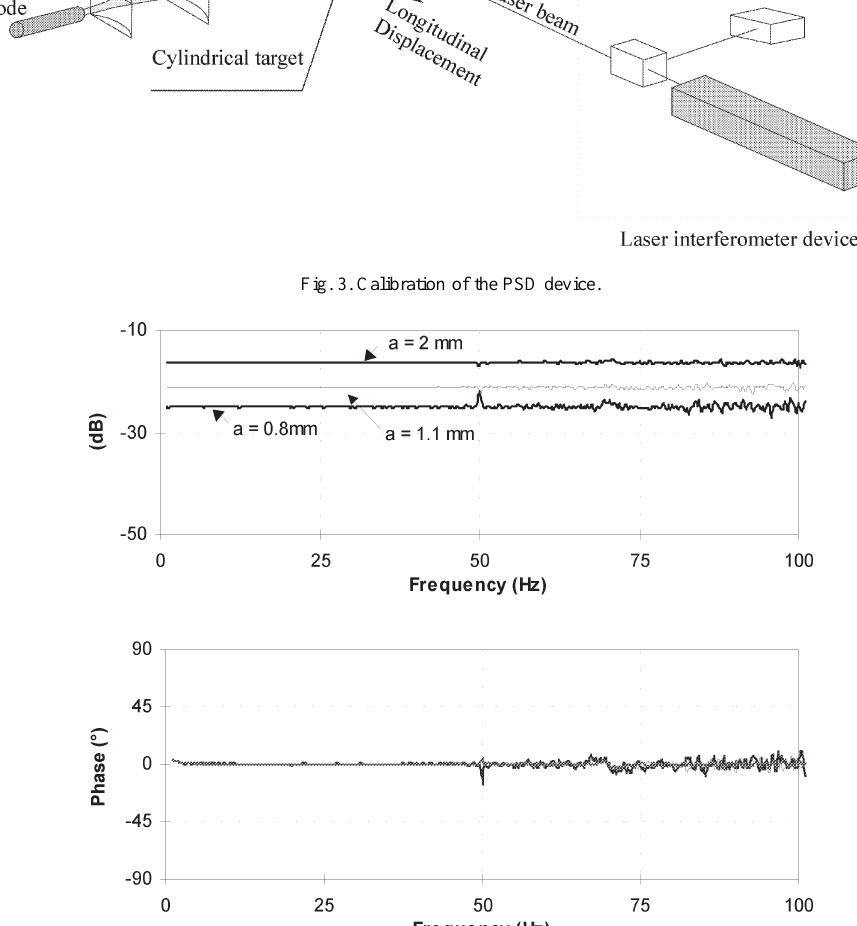
Fig. 4. Frequency response function between the laser interferometer displacement signal and the PSD output measurement (0–100